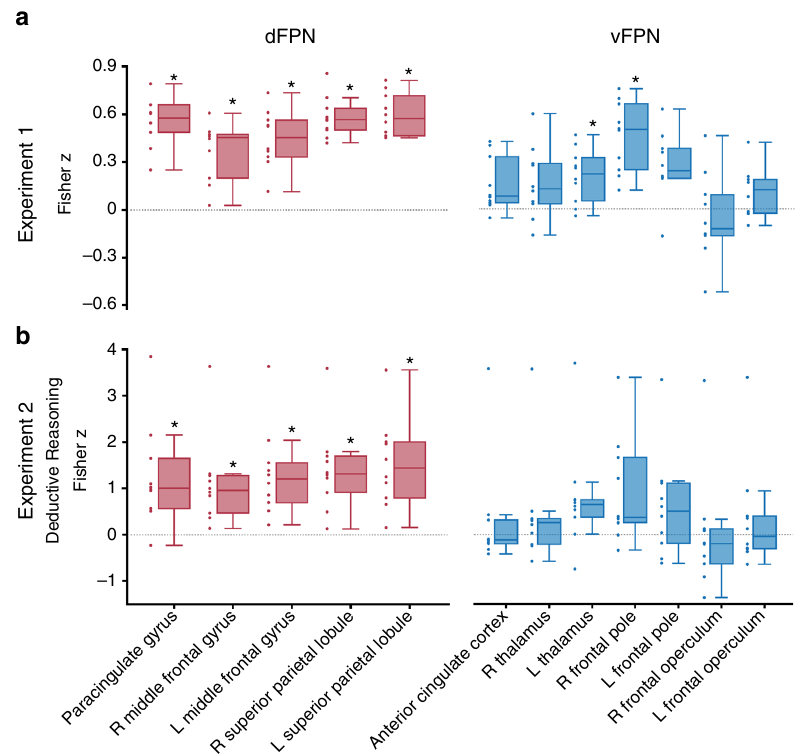
Fig. 3 Post-hoc cluster-based analyses within dFPN and vFPN. To demonstrate that the optimization method selected tasks (Experiment 1) and task parameters (Experiment 2) that selectively targeted the entire dFPN, we performed post-hoc whole-brain back-projections (see Methods section — Post- hoc cluster-based analyses within dFPN and vFPN). Asterisks (*) indicate signi fi cant fi ndings ( p < 0.05) after correcting for multiple comparisons using permutation testing (critical t (9) = 3.46 for Experiment 1; critical t (9) = 2.63 for Experiment 2). a We fi nd that for Experiment 1 identi fi ed tasks optimally increased the contrast with the vFPN across the entire dFPN, i.e., our obtained real-time results were not driven by single clusters within the dFPN. In comparison, most regions within the vFPN did not differ from zero; this was expected (since we contrasted beta-coef fi cients from each voxel ’ s time series with the beta-coef fi cients of the vFPN). b This result was replicated for the Deductive Reasoning task in Experiment 2. This analysis was not carried out for the Tower of London task because the group-level predictions were different from the subject-level results (see Supplementary Fig. 6). On each box, the central mark is the median, the edges of the box are the 25th and 75th percentiles, the whiskers extend to the most extreme datapoints considered not to be outliers. Left to each plot are all individual observations ( n = 10 for both